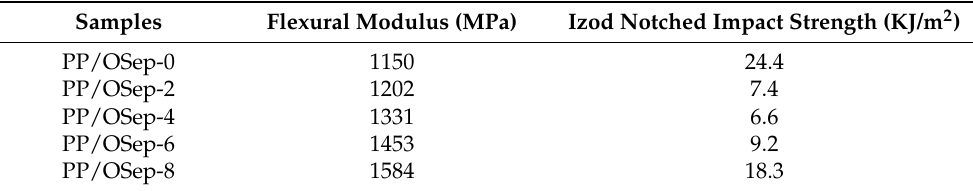
Table 4. Mechanical properties of PP/OSep